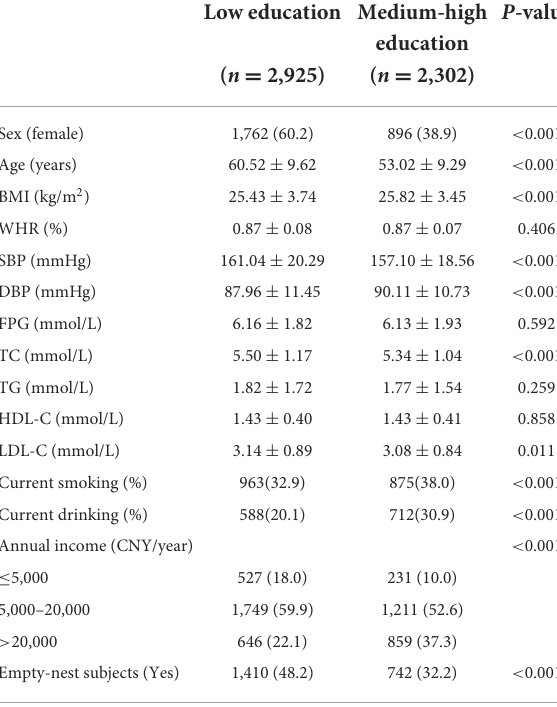
TABLE 2 Prevalence of comorbidities and echocardiographic parameters in hypertensives subdivided according to educational